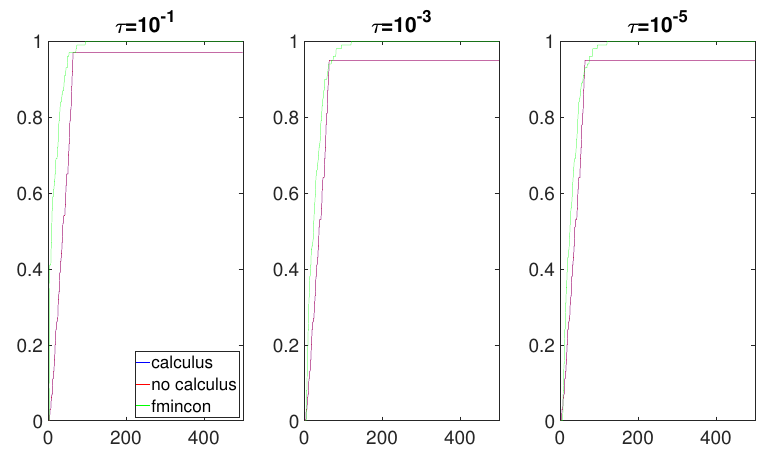
Figure 1. Data profiles when F = f 1 · f 2 and when f 1 , f 2 are linear functions.